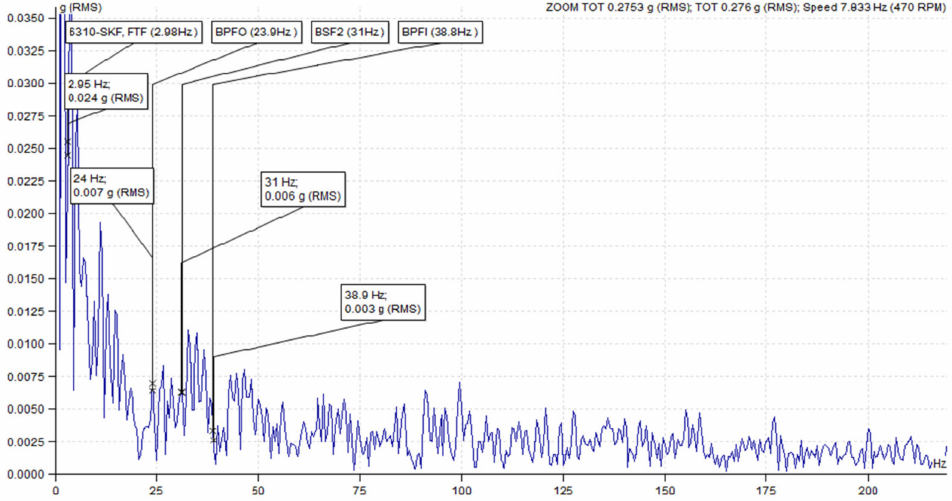
Figure 11. The fast Fourier transform (FFT) (500 Hz–16 kHz) demodulation of the 6310 SKF of the non-driving end of the threshing drum of Massey Ferguson 7374 s (1300 EH) Activa, a sensor mounted on a